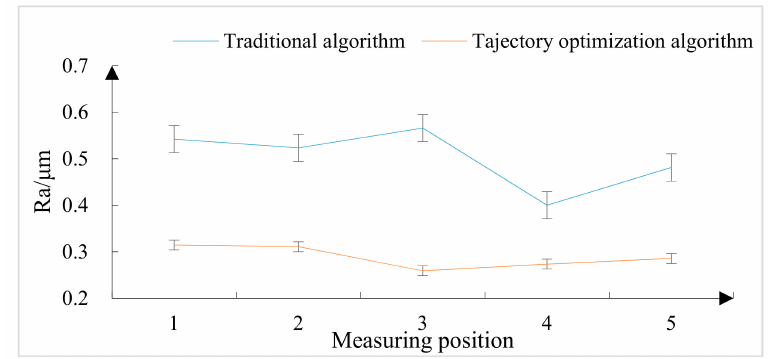
Figure 20. Traditional algorithm and trajectory optimization algorithm experimental roughness measurement line